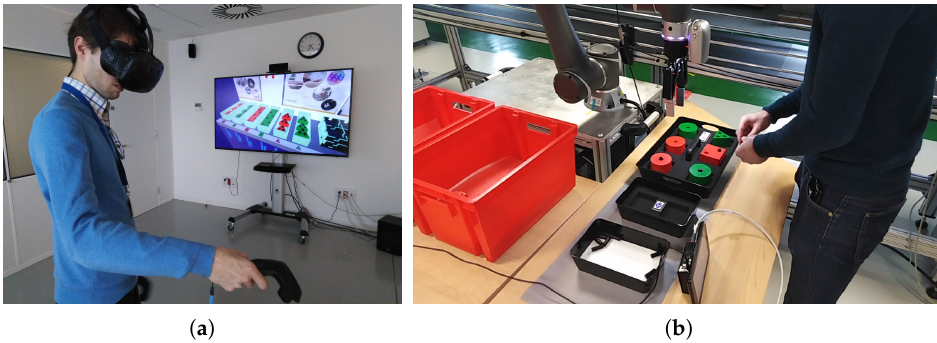
Figure 13. Tests and validation: ( a ) tester in the virtual scenario, and ( b ) tester in the real